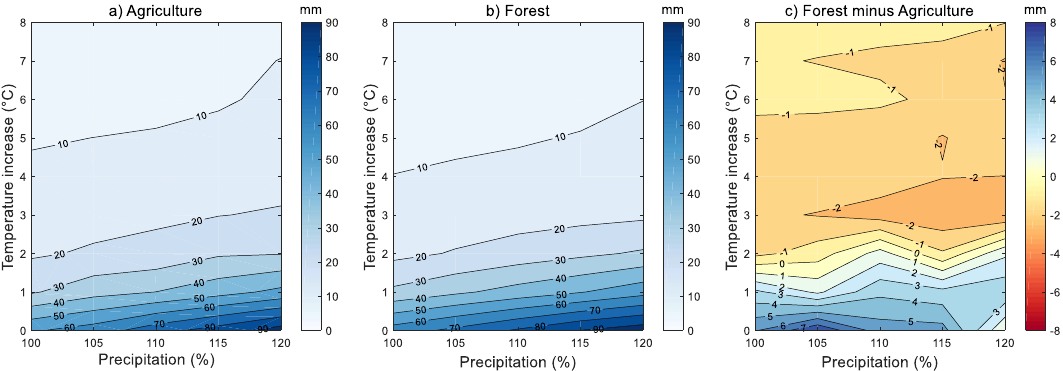
Figure 10. Peak SWE in response to temperature and precipitation changes in ( a ) agriculture, ( b ) forest, and ( c ) difference between forest and agriculture.